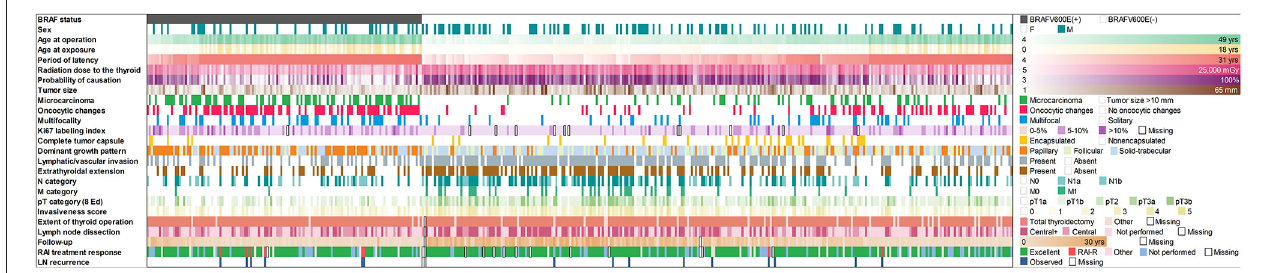
FIGURE 1 | Baseline, radiation exposure, and clinicopathological profiles of 428 radiogenic PTCs in the study arranged by IHC BRAF status.